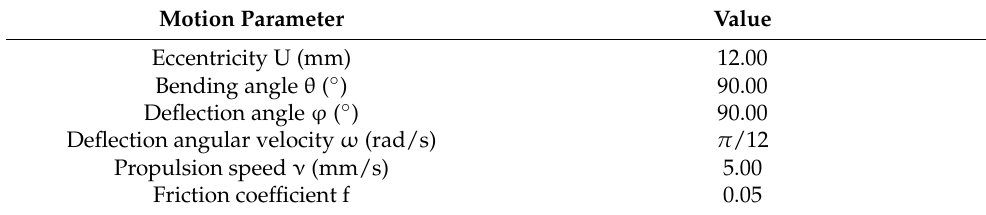
Figure 6. Three-dimensional free bending finite element model. Table 3. The motion parameters of 3D free bending finite element model.